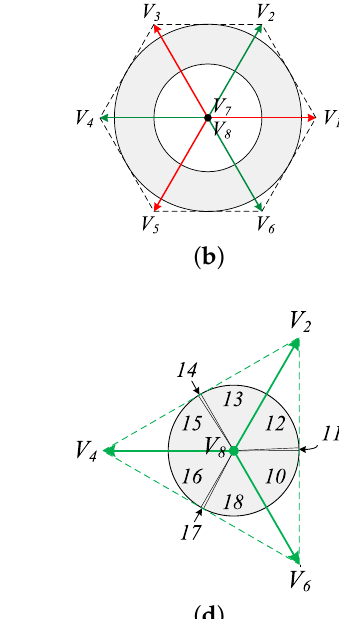
√ 3/2 ) . ( c ) Feasability region ( m < 0.5 )